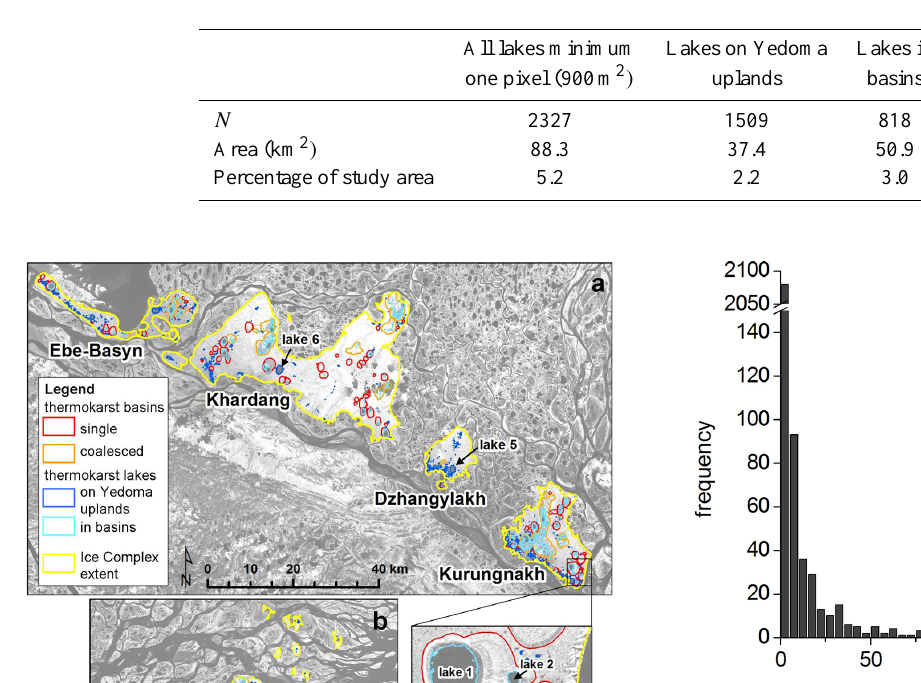
Table 2. Area calculations for water bodies on the third Lena Delta terrace (except bedrock islands).